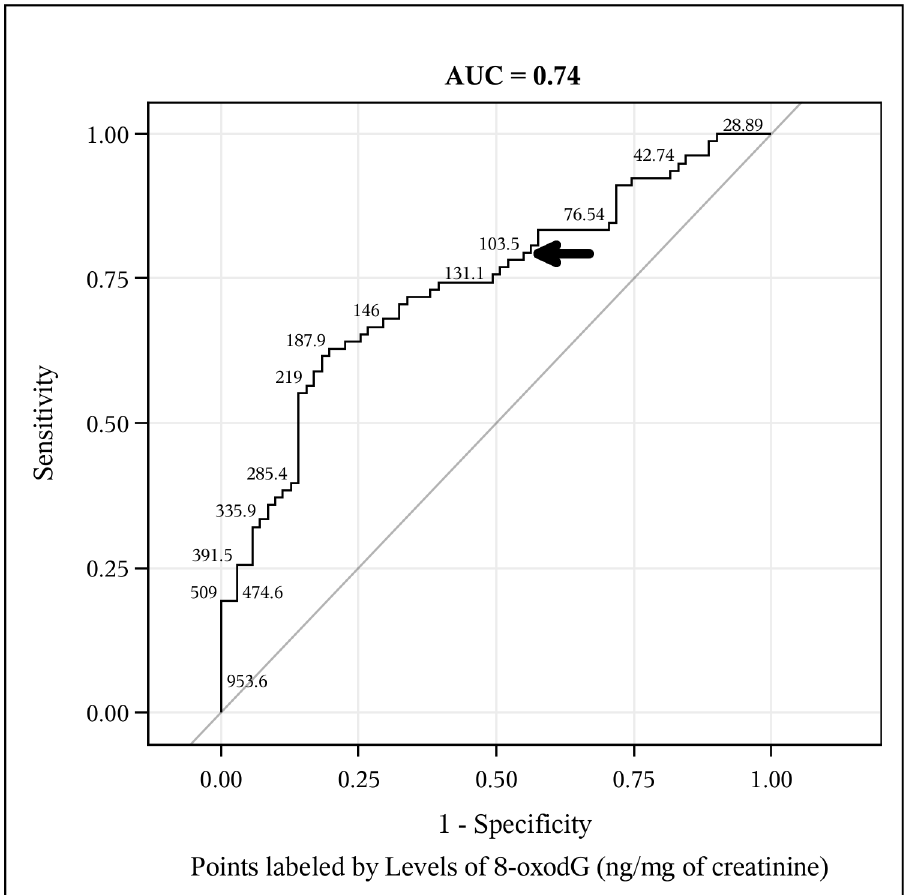
Fig 3. Levels of urine 8-oxodG detected by immunoassay can identify O . viverrini infected individuals with advanced periductal fibrosis (APF). The Receiver Operating Characteristic (ROC) curve illustrates the predictive power of urinary 8-oxodG in identifying APF+ individuals. The predictive power of the assay, measured by the area under curve (AUC) is 74%. The curve is labeled with selected actual amounts of 8-oxodG (ng/mg) detected in study participants; labeled points are presented, at random, in a way to maximize legibility. The model used to construct the ROC curve included negative controls (EN and APF- individuals, n = 71) and APF+ individuals (n = 78). The bold arrow points to the concentration of urine 8-oxodG identified as an optimal diagnostic threshold for corroborating APF